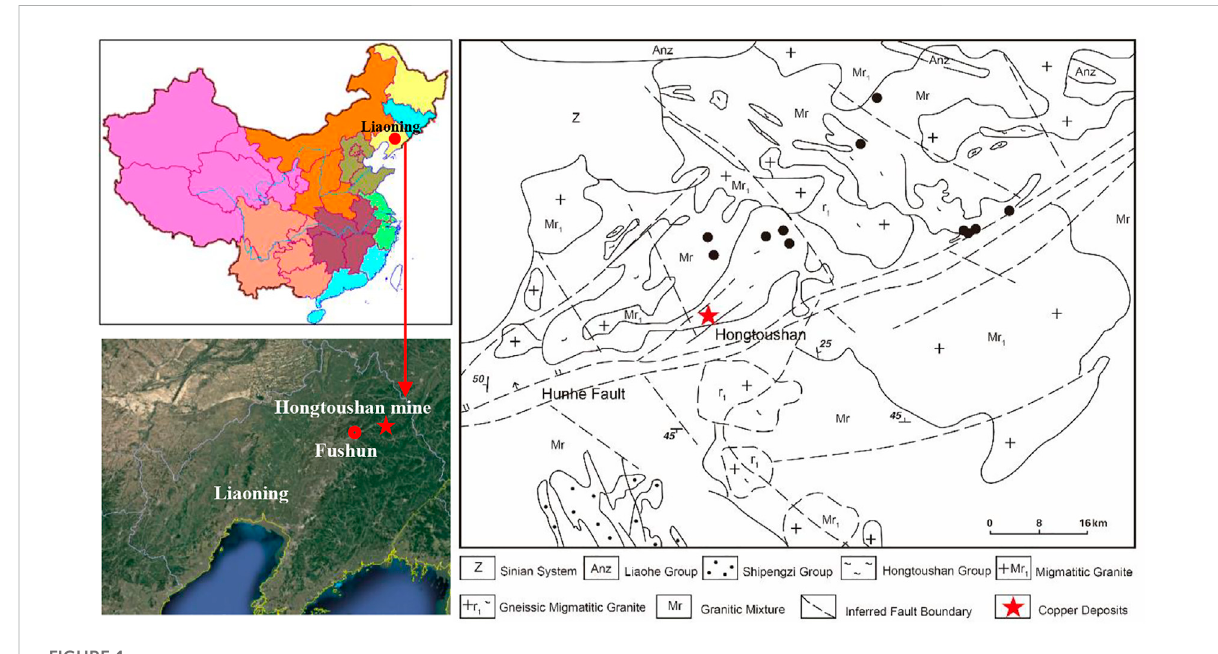
FIGURE 1 Location and regional geology of the Hongtoushan